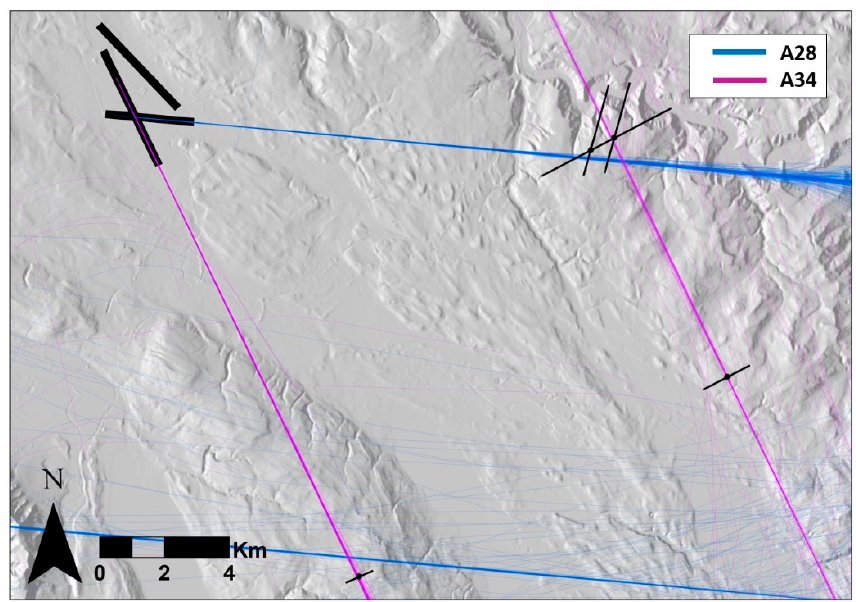
Figure 2. Noise monitoring terminals (NMT) in close range to GVA with all flight trajectories used for this study, colored by procedure. The black circles around each terminal represent spatial gates, which the flight trajectories have to penetrate to be considered (basemap: swissALTI3D LV95, swis- stopo; source: Federal Office of Topography).